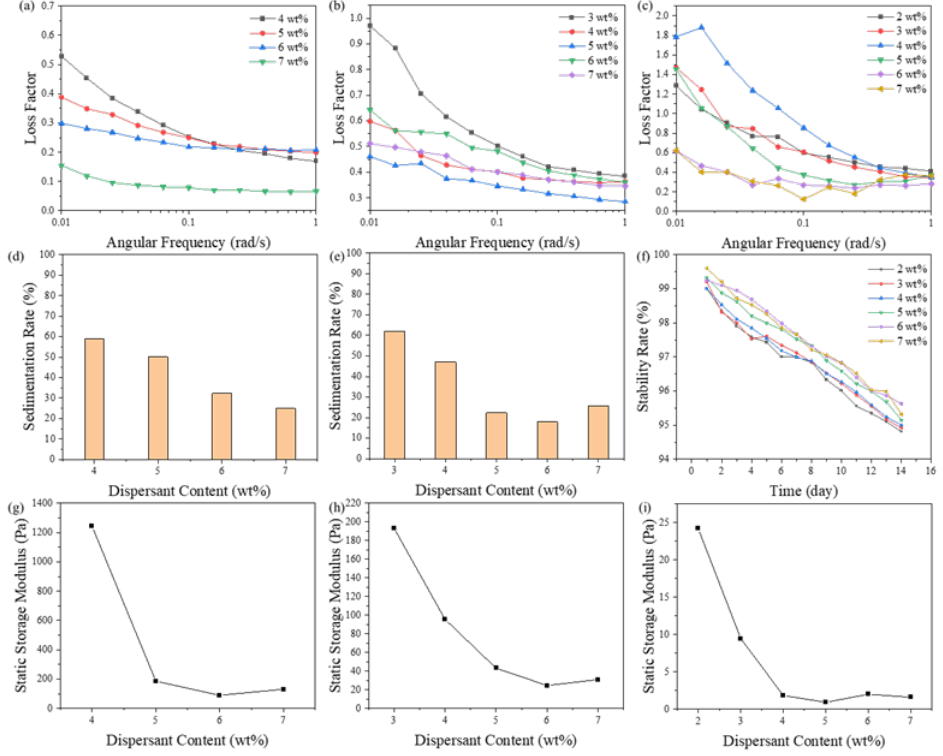
Figure 7. The effects of dispersant content on loss factor under various angular frequency in ( a ) ZF2, ( b ) ZF5, ( c ) ZF10 slurries, stability of ( d ) ZF2, ( e ) ZF5, ( f ) ZF10 slurries, and static storage modulus of ( g ) ZF2, ( h ) ZF5, ( i ) ZF10 slurries.